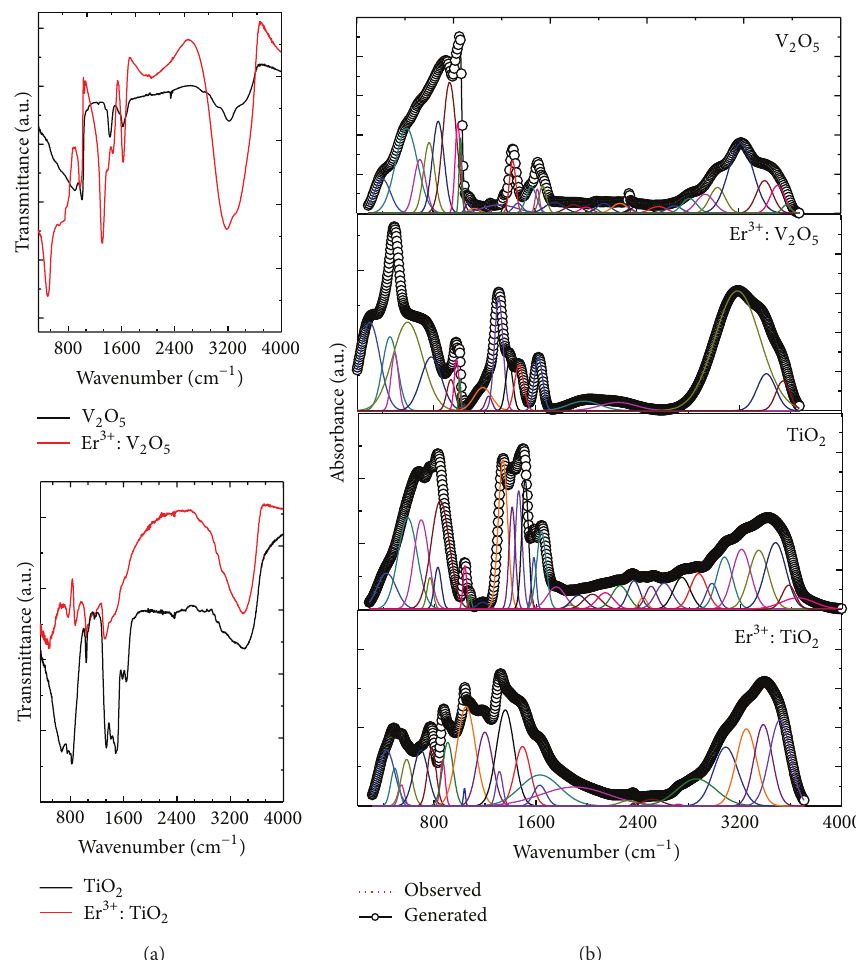
Figure 2: FTIR (a) transmittance and (b) deconvolution spectra of the films deposited on ITO coated glass substrates.